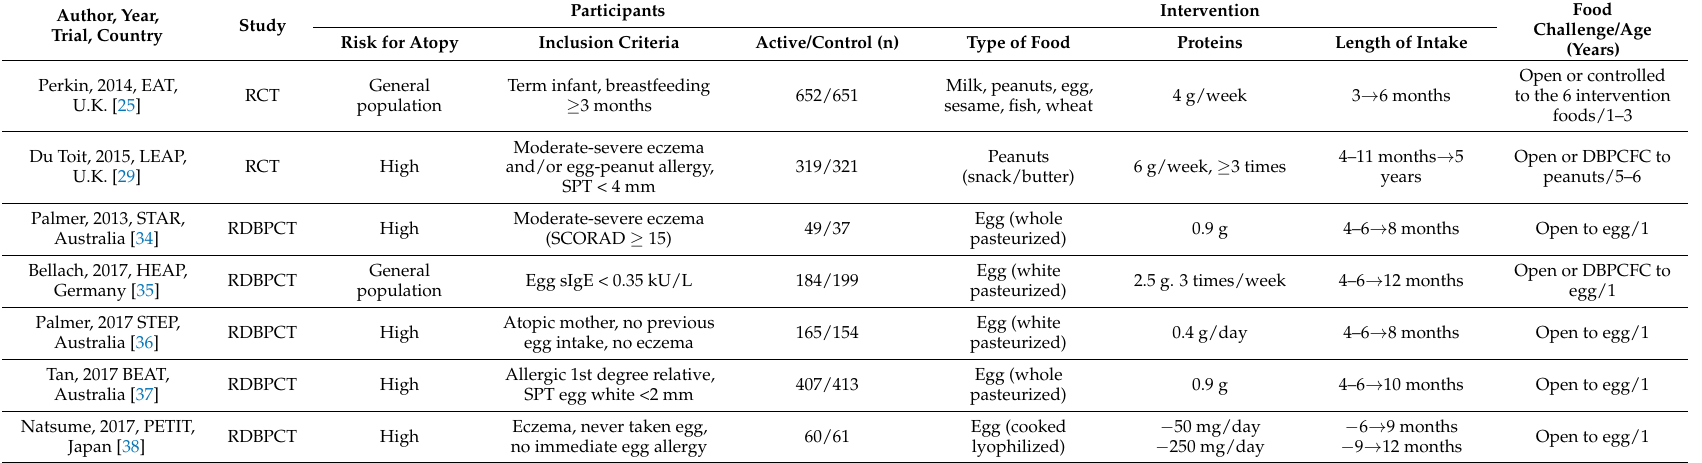
Table 1. Randomized trials on solid food introduction and development of food allergy. SPT, skin prick